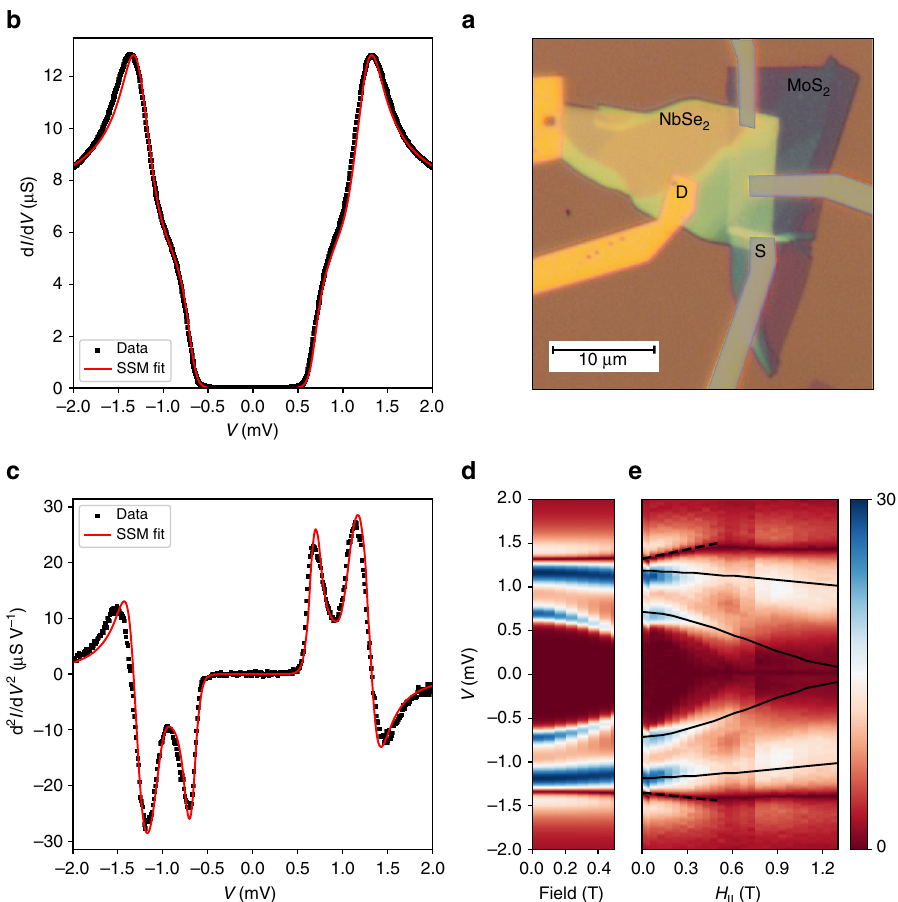
Fig. 1 Differential conductance of a bulk NbSe 2 tunnel device. a Optical image of the tunnel junction device. The yellow-green fl ake is a 50 – 20 nm thick NbSe 2 (20 nm at the source electrode) and the purple-blue fl ake is a 4 – 5 layer MoS 2 . Au electrodes are deposited on the left to serve as ohmic contacts (yellow) and on the right to serve as tunnel electrodes (purple). b d I /d V vs. V as measured on the device shown in a (black) and a fi t to the SSM model (red, see details in the text, all fi t parameters are given in Supplementary Note 3 and Supplementary Table 1). c d 2 I /d V 2 of the data in b , and the fi t to the (cid:5) SSM model. d Simulated d 2 I = d V 2